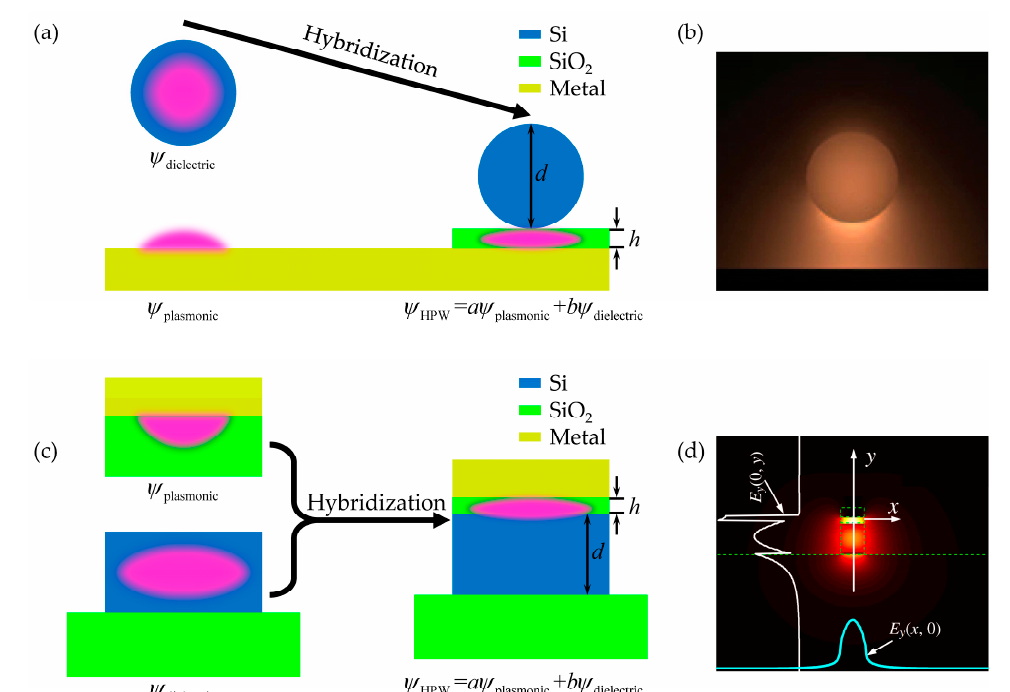
Figure 5. Schematics ( a , c ) and field distributions ( b , d ) of two types of hybrid plasmonic waveguides reported in literature. ( a , b ) A dielectric cylinder above a metal surface [106]. ( c , d ) A metal cap on an SOI slab with a low-index nano-layer between them [104]. This type of hybrid plasmonic waveguide is compatible with standard processes for SOI wafers and is thus easily fabricated. Figures reproduced from ( b ) [106]; ( d ) [104].